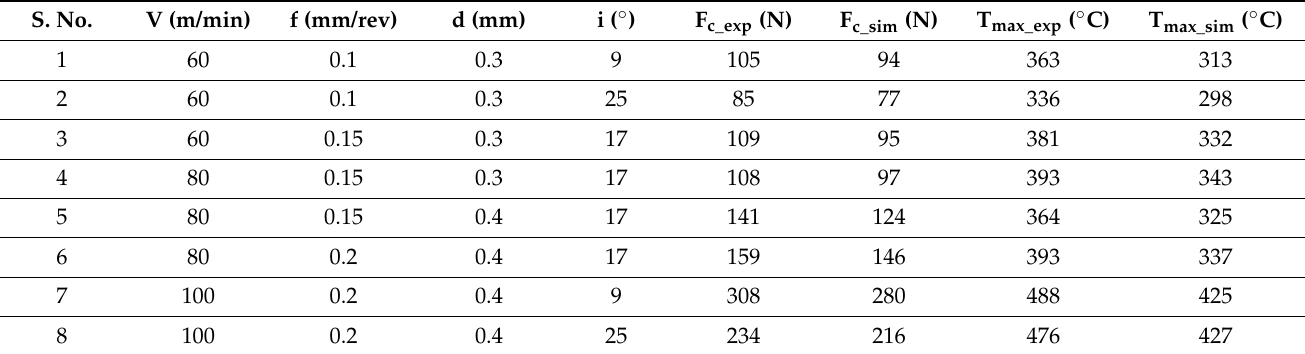
Table 4. Cutting force and temperature from experiments and simulations.